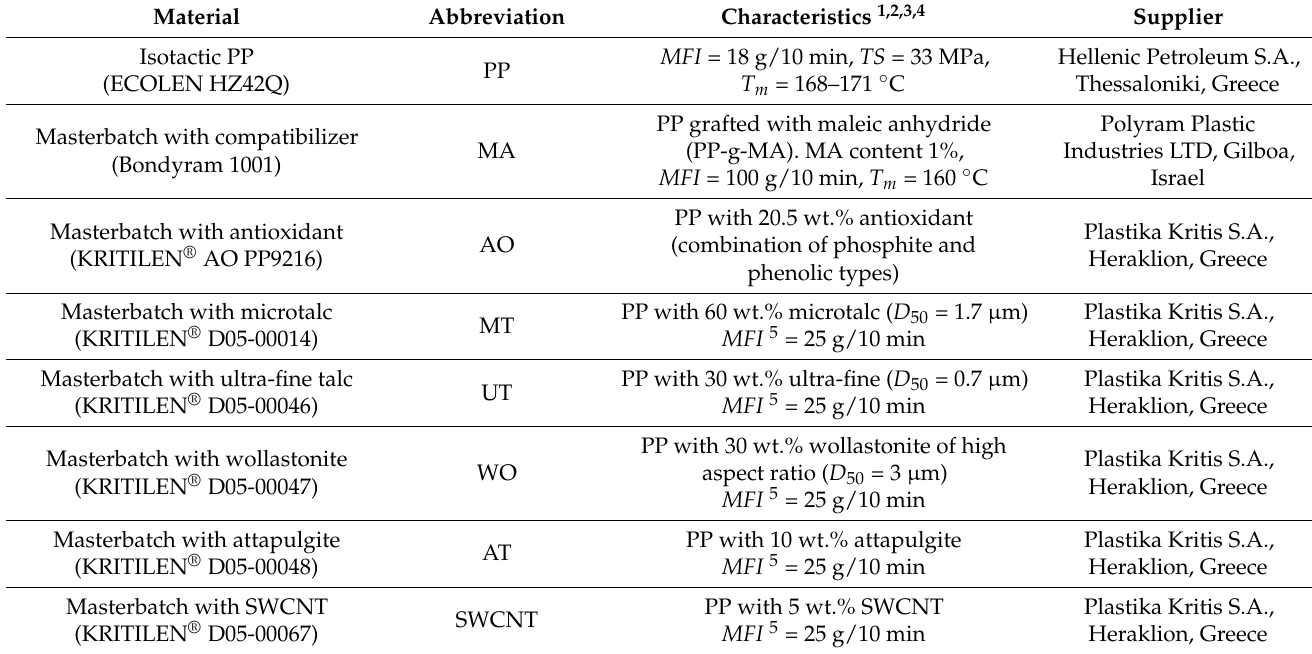
Table 1. Important characteristics of the used